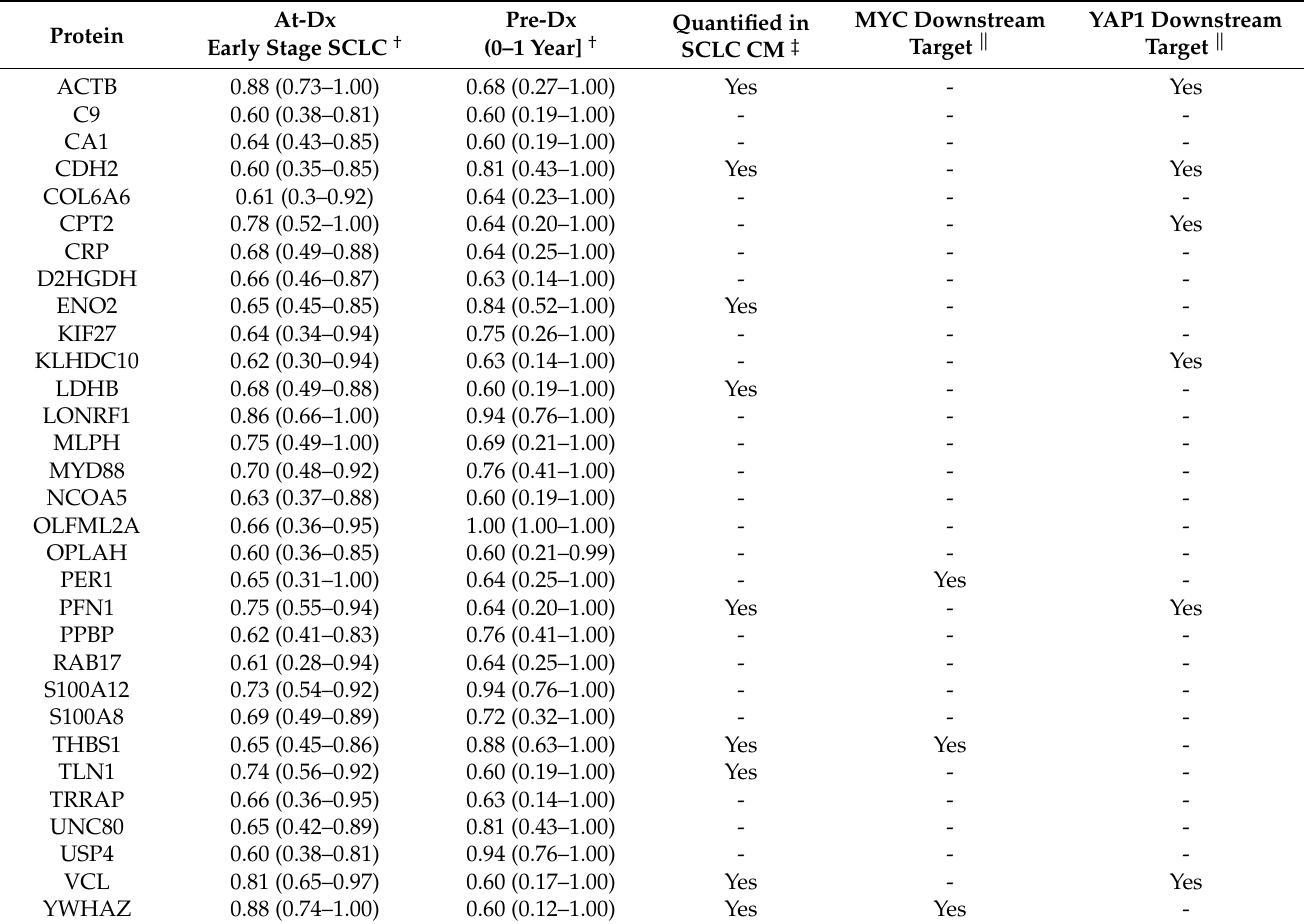
† AUC (95% confidence interval) for distinguishing cases from matched controls. ‡ Proteins quantified in conditioned medium of SCLC cell lines are provided in Supplemental Dataset S2. (cid:107) ChIP Enrichment Analysis (ChEA) transcriptional targets of c-MYC and YAP1 were derived from Harmonizome